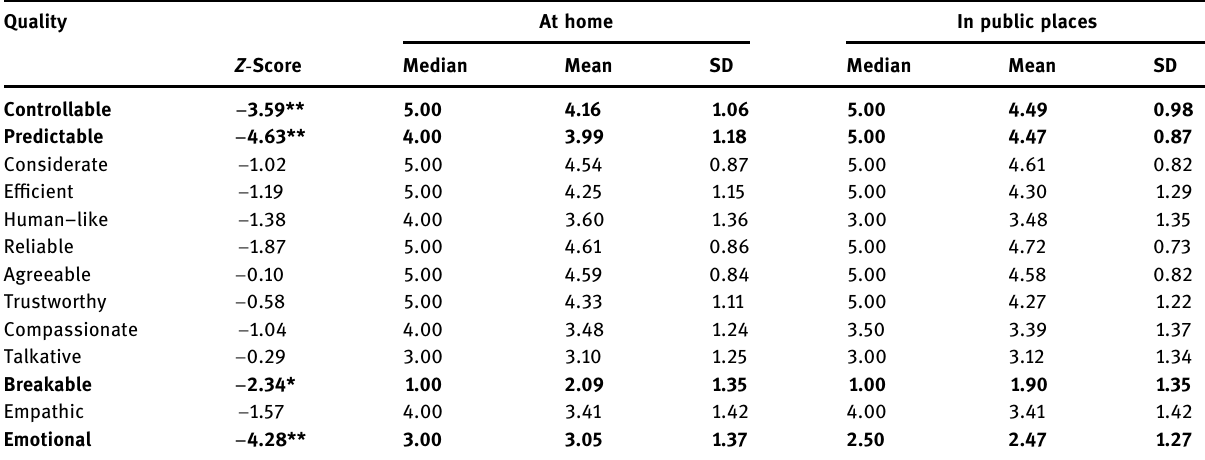
Table 11: Results of the Wilcoxon signed - rank test between characteristics of a robot at home and in public places Quality At home In public places